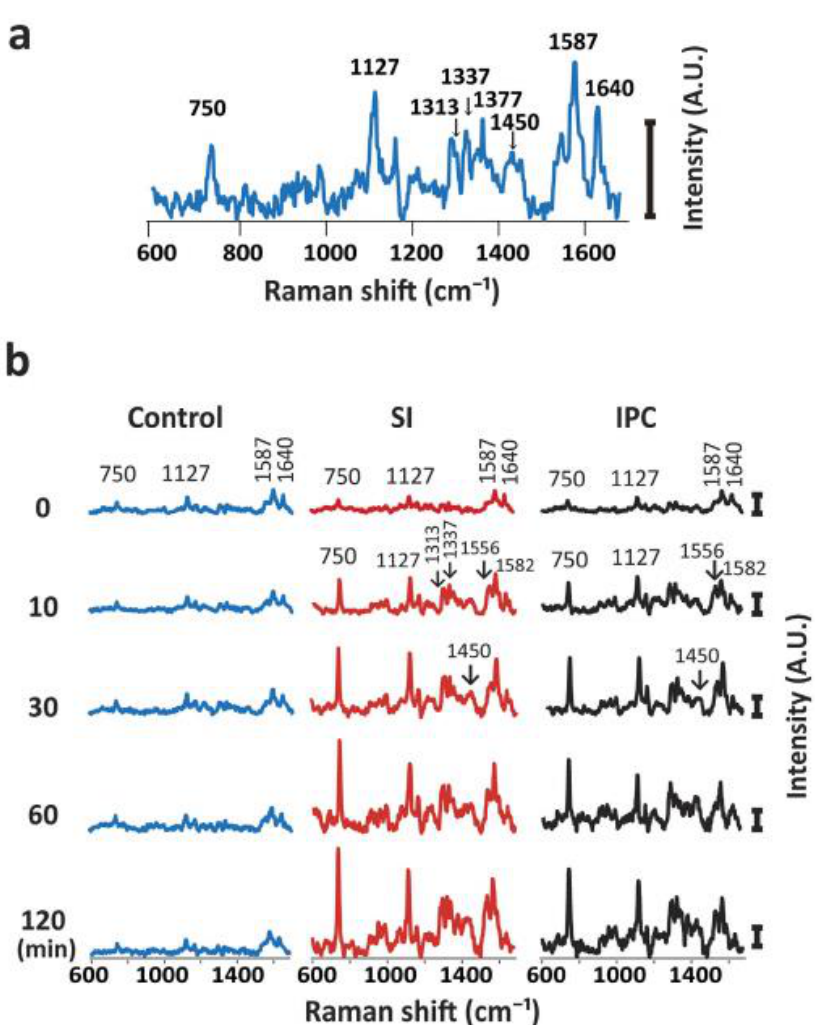
Figure 3. ( a ) Raman spectrum of the perfused rat heart under rest conditions with normoxia. ( b ) Raman spectra of rat hearts under perfusion (blue spectra), under 120 min. of global heart ischemia (red spectra) and under 120 min. of global hypoxia with the ischemic preconditioning (black spectra). Reprinted from [93] with permission by Creative Commons License.